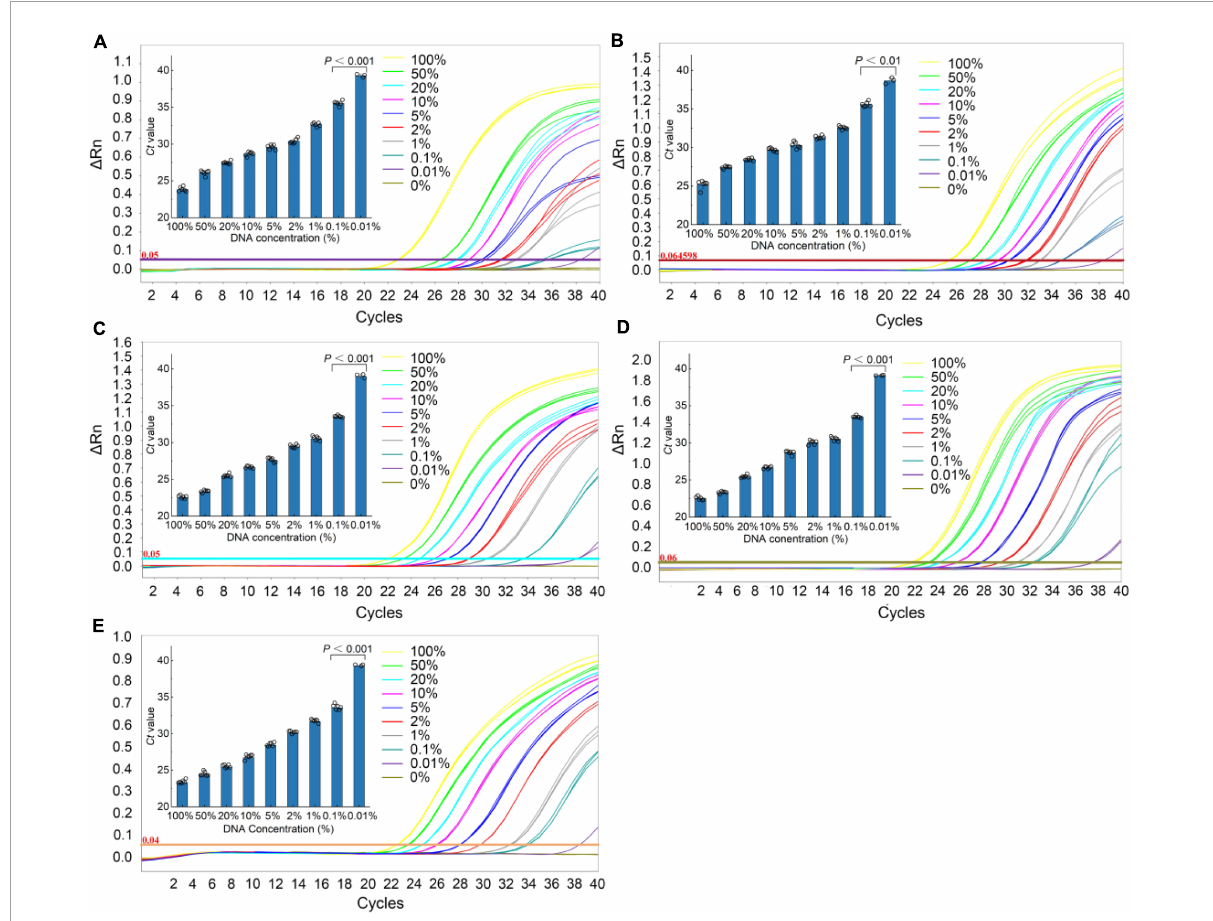
FIGURE5 Real-time qPCR results of the sensitivity analyses. Typical fluorescence curves of qPCR method corresponding to the addition of different percentage of different species puffer fish added into mixture meat ranging from 0 to 100% (0, 0.001, 0.1, 1, 2, 5, 10, 20, 50, and 100%). Inner: the Ct value for the samples with 0.001–100% puffer fish. (A) L. inermis , (B) L. lagocephalus , (C) L. gloveri , (D) L. lunaris , (E) L. spadiceus . All values are presented as mean ± s.d. Statistical significances were obtained by the Mann Whitney